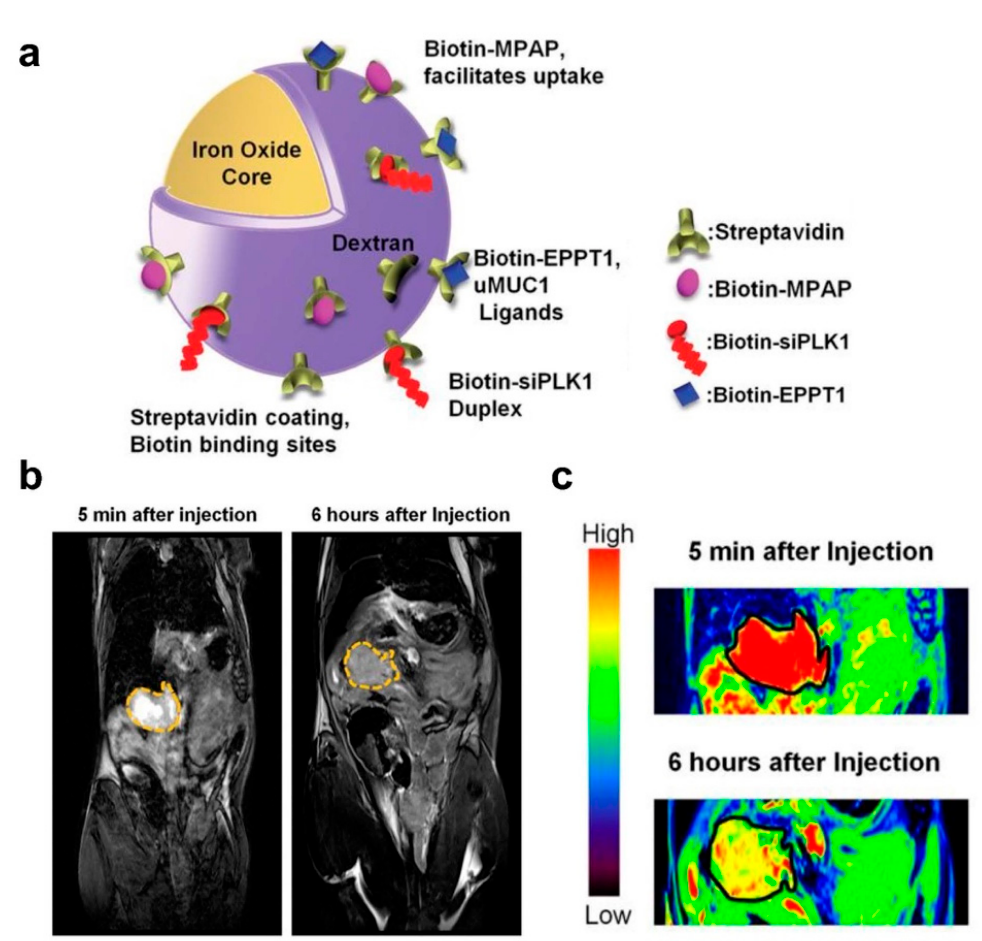
Figure 3. IONPs for gene delivery and in vivo tumor imaging. ( a ) Schematic representation of siPLK1 − StAv − SPIONs. ( b ) In vivo MRI of mice bearing syngeneic orthotopic tumors was performed before and 6 h after intravenous injection of siPLK1 − StAv − SPIONs. The dashed line marks the periphery of the tumor. ( c ) Color contrast images show decreased T2 relaxivity compared to pre − injection. Reprinted with permission from Ref. [86]. Copyright 2016, BMJ Publishing Group Ltd. and British Society of Gastroenterology.